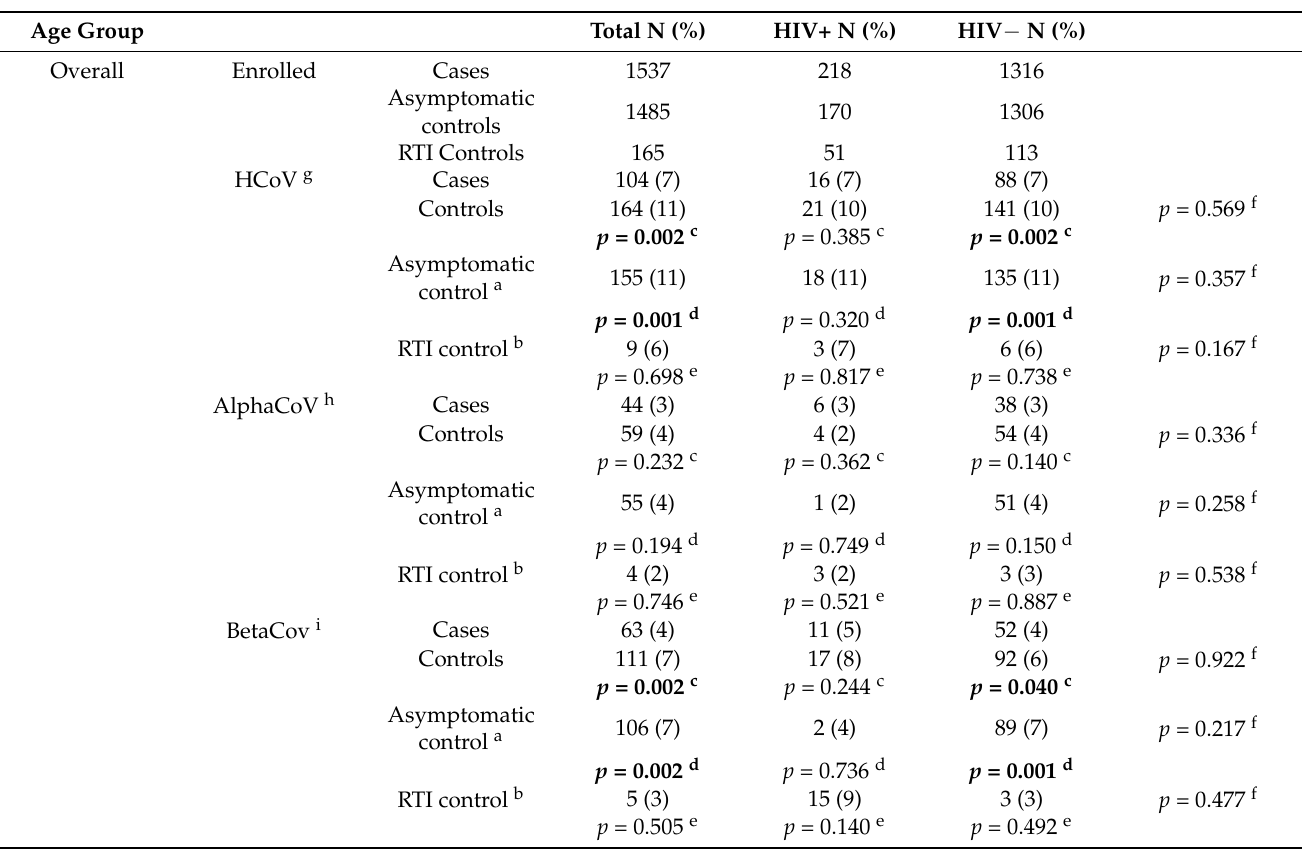
Table 1. Number of study subjects enrolled and tested for HCoV—percent positive by age and HIV-1 infection status. Age